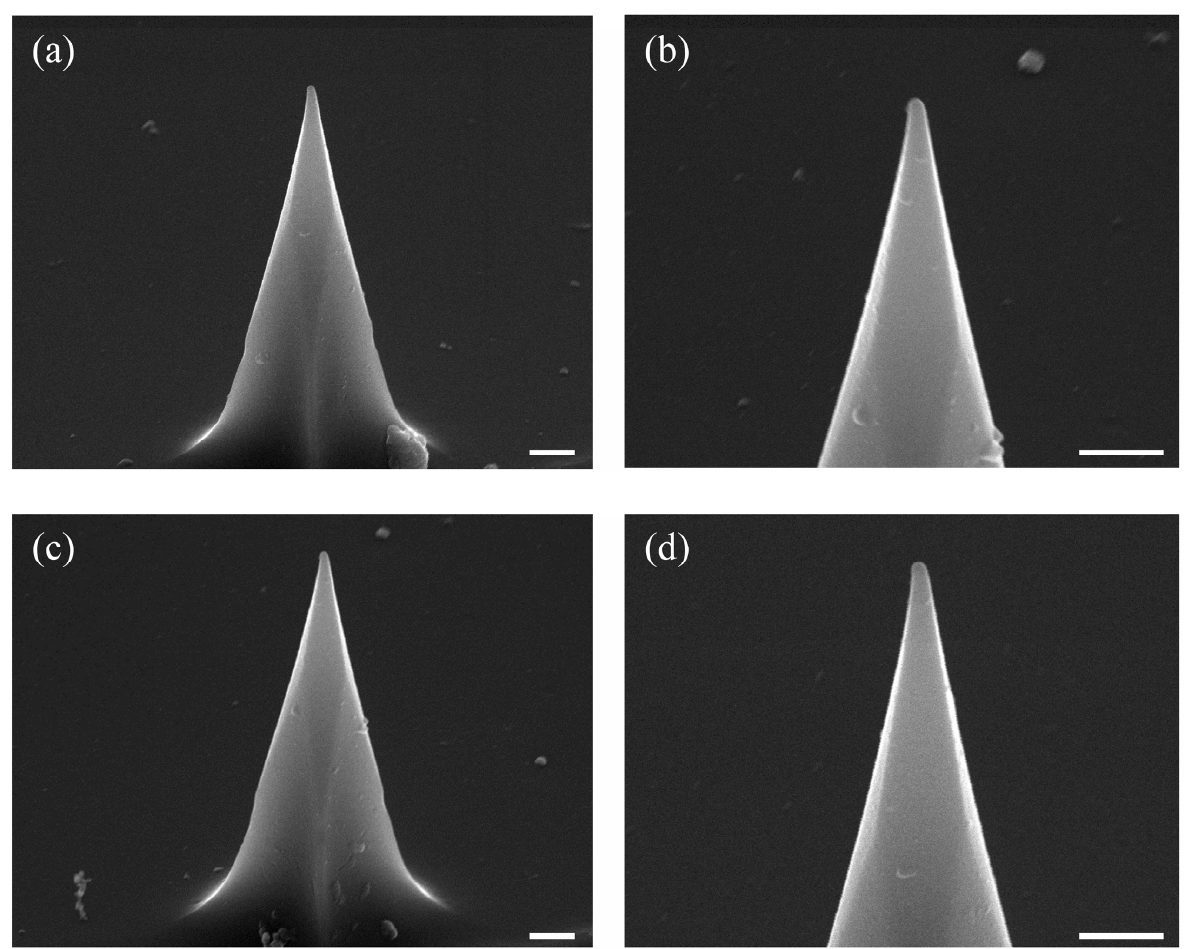
Figure 6. SEM images of ( a , b ) a new DCP20 probe and ( c , d ) the same probe used for P-AFL tests; the scale bars in the SEM figure correspond to 1